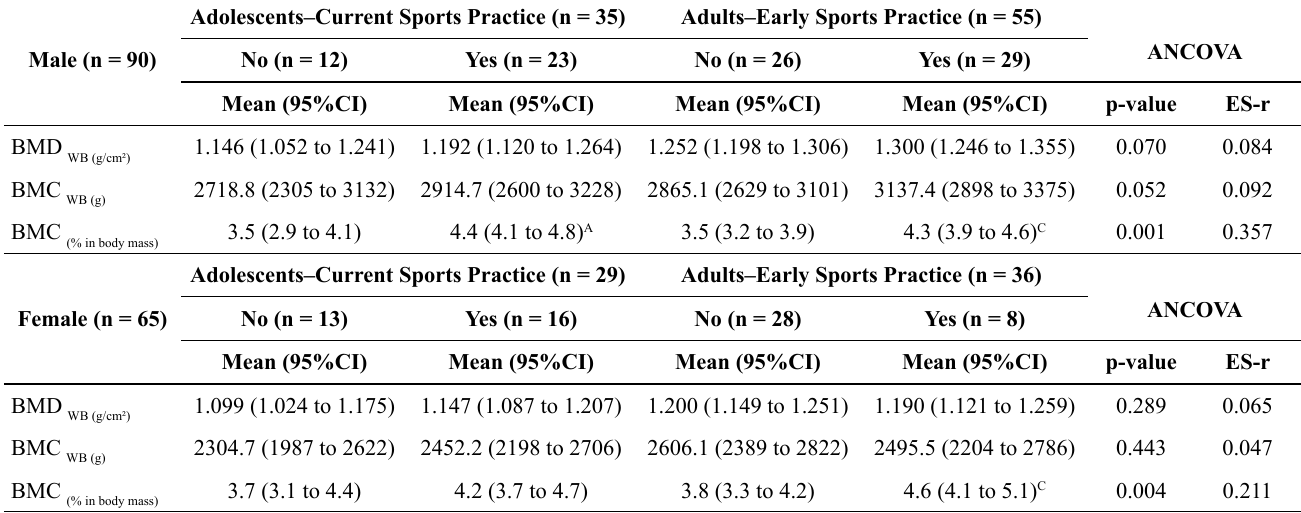
Table 3 . Bone characteristics (ANCOVA estimated means) of the sample stratified by gender and sport practice (n = 155)